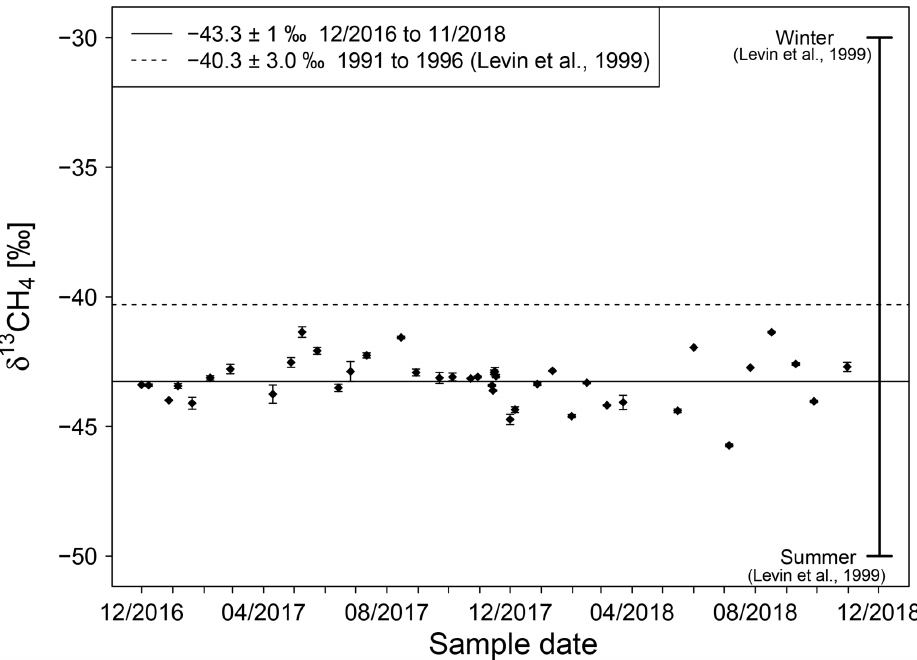
Figure 6. Isotopic signature of natural gas in Heidelberg measured between end of 2016 and November 2018. The horizontal solid line is the average monthly mean δ 13 CH 4 value. The horizontal dashed line is the average δ 13 CH 4 value measured from 1991 to 1996 with data ranging from − 50‰ in summer to − 30‰ in winter (Levin et al.,